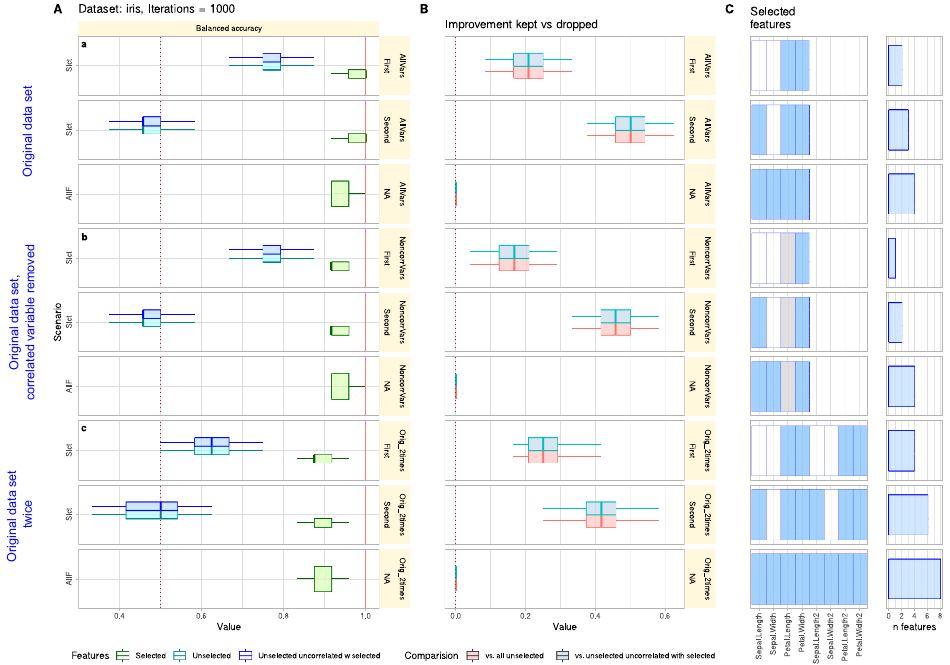
Figure 1. Feature selection and classification performance evaluation with different feature sets in the iris data set [28]. The graph is divided into subgraphs a–c from top to bottom. Experiments were performed ( a ) with the original data, ( b ) with the iris data set omitting one highly correlated variable, and ( c ) with the data set adding all variables twice. Each subgraph is organized in three further subgraphs, showing from top to bottom (i) the results when using the features selected in the default feature selection, (ii) the features added when performing a second feature selection on the unselected features from the first selection, and (iii) when training the algorithm with the full feature set. The boxes show the 25th, 50th (blue vertical line), and 75th percentiles of balanced accuracies obtained in 1000 repeated runs with a random selection of 67% from the training data set and 80% from a validation data set separated from the data set before feature selection. Whiskers span the 95% confidence interval from the 2.5th to the 97.5th percentiles. ( A ): Balanced accuracy obtained with a random forests classifier trained with (i) the selected features, (ii) the unselected features, and (iii) the unselected features that were not highly correlated with the selected features, with the correlation threshold set at a very strong correlation of ρ > 0.9. ( B ): Difference in balanced accuracy when algorithms were trained with the selected versus unselected features. ( C ): Selected features (blue) and unselected features (white). Features excluded from the experiments due to very strong correlation are shown in